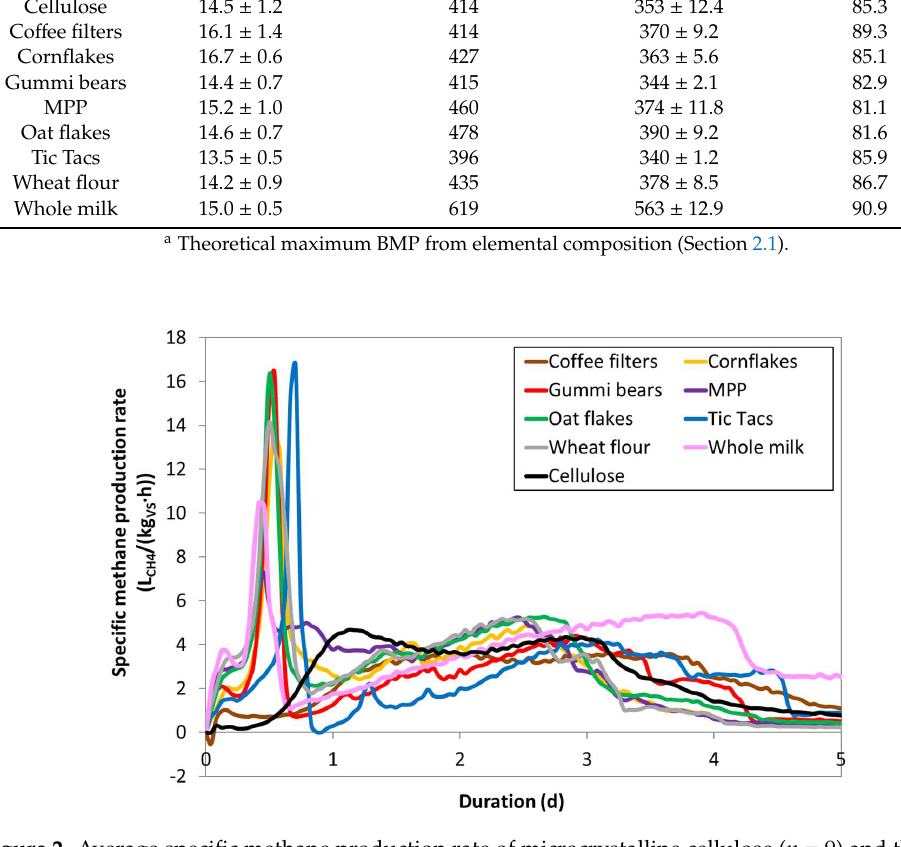
Figure 2. Average specific methane production rate of microcrystalline cellulose ( n = 9) and the eight alternative positive control substrates ( n = 3) tested in the first 5 days of incubation.